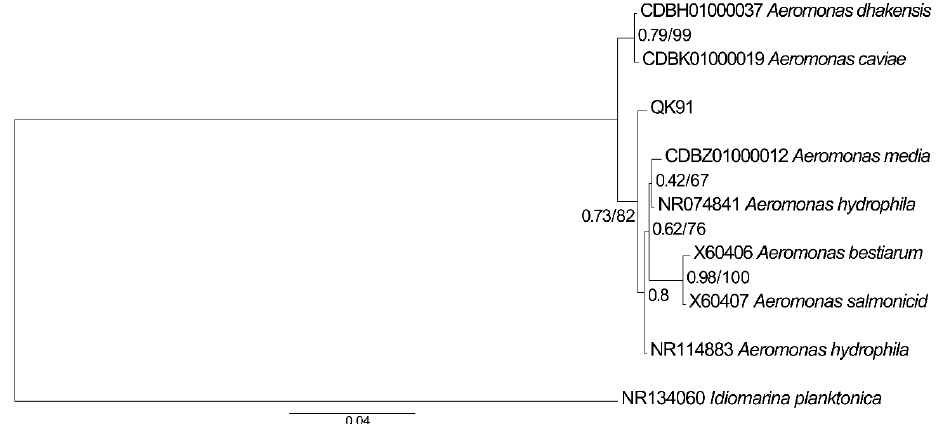
Figure 3. Bayesian phylogenetic tree of 91 # strain based on 16S rDNA. The numbers on the left and right sides of the branch represent the approximate Bayesian test support value and the Neighbor- Joining method bootstrap value.